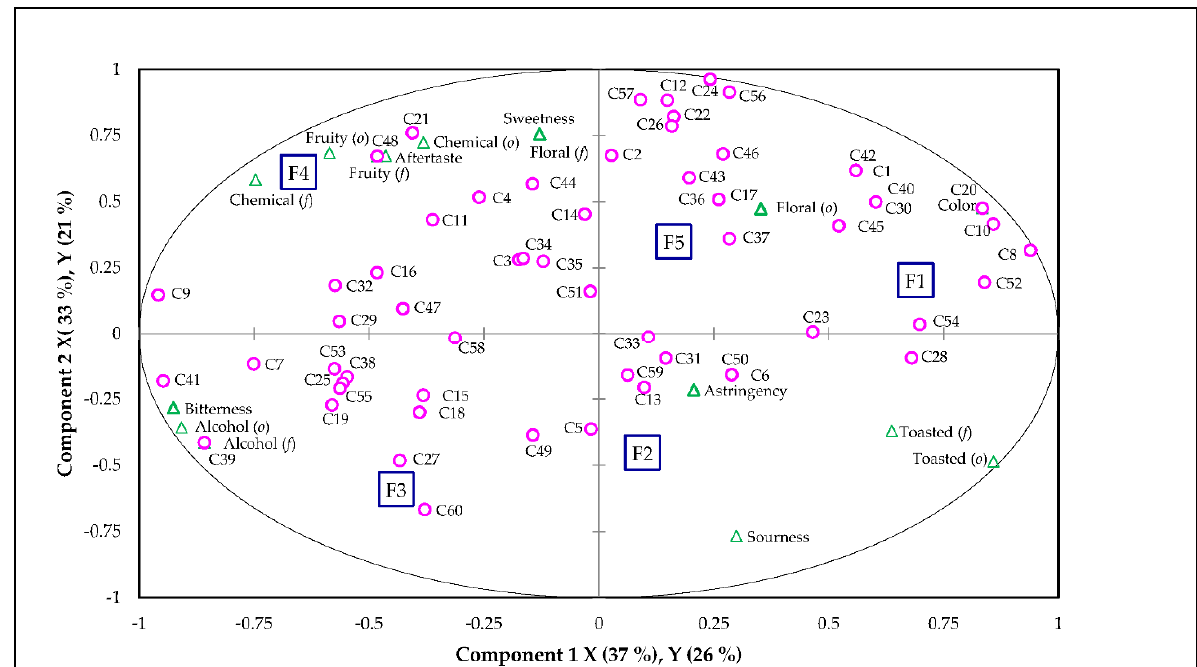
Figure 2. Partial Least Squares (PLS) regression of descriptive sensory attributes (X − axis) and consumers overall liking (Y − axis) of Fondillón samples under analysis. Legend : C consumers; Sample; sensory attributes, consumer´s overall liking.